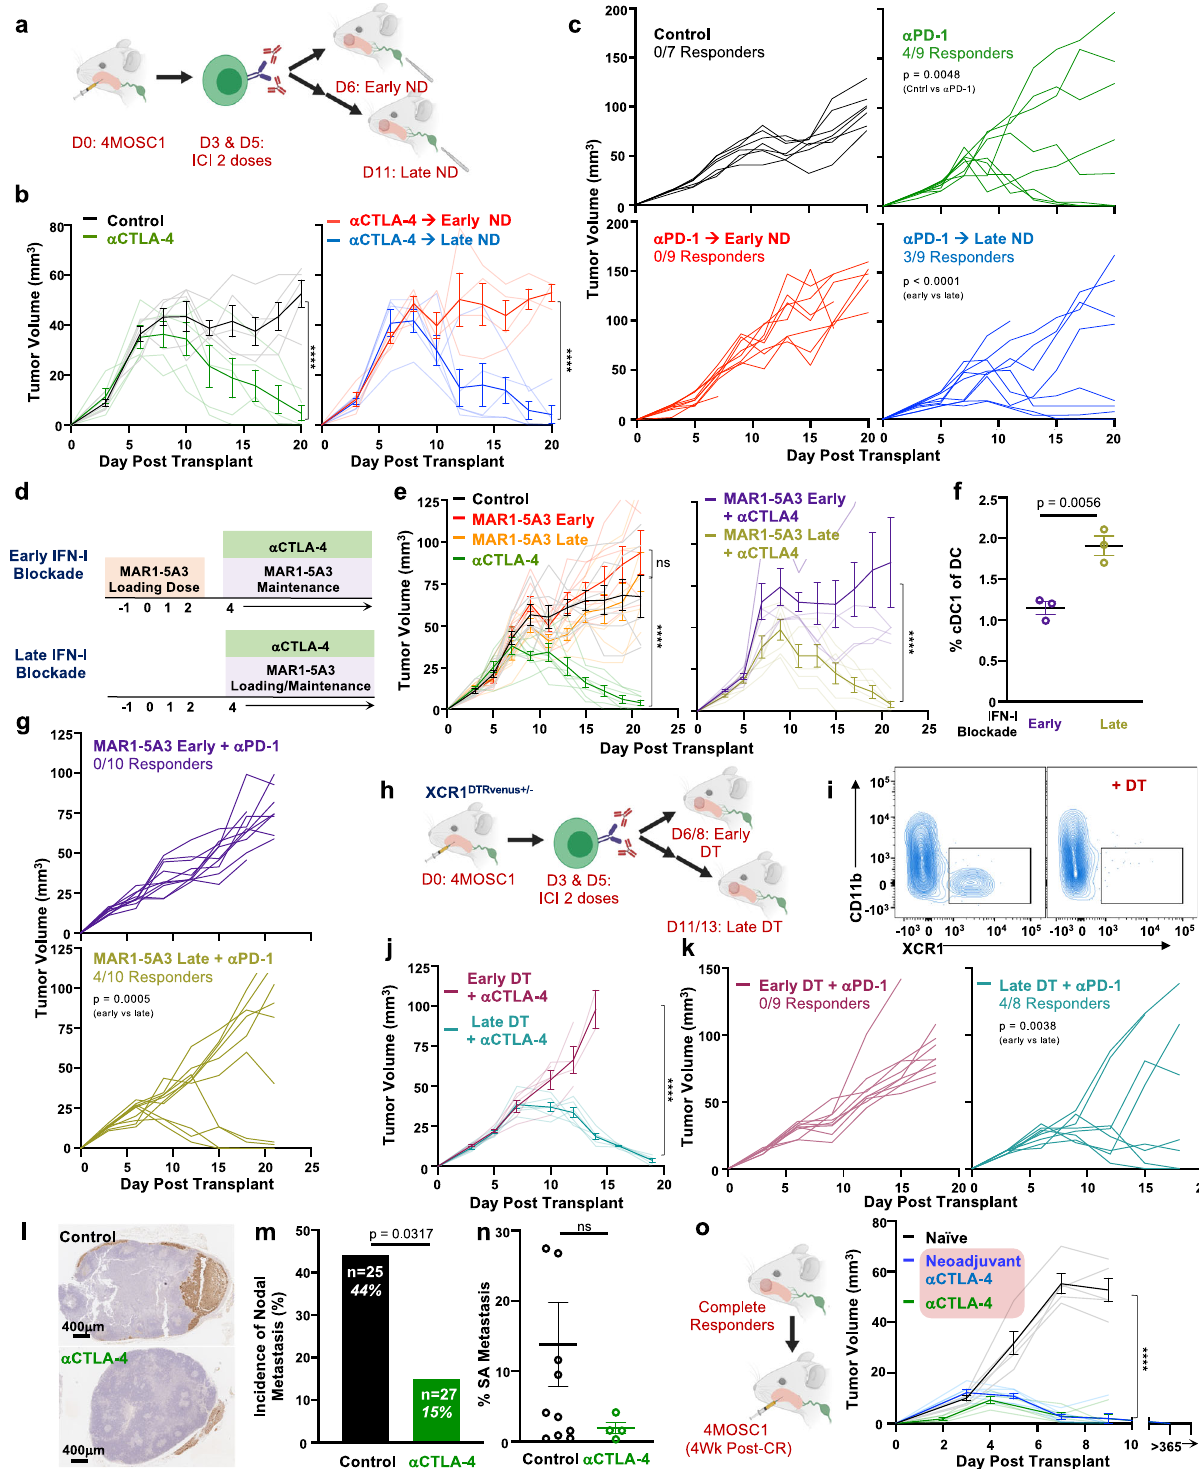
RNAseq at a timepoint following delayed neck dissection but preceding a signi fi cant change in the tumor volume between treatment cohorts (Fig. 6a). Principle component analysis of the transcriptome from whole blood between these groups reveals that the timing of surgery alone alters the global transcriptome of the peripheral immune compartment (Fig. 6b). To